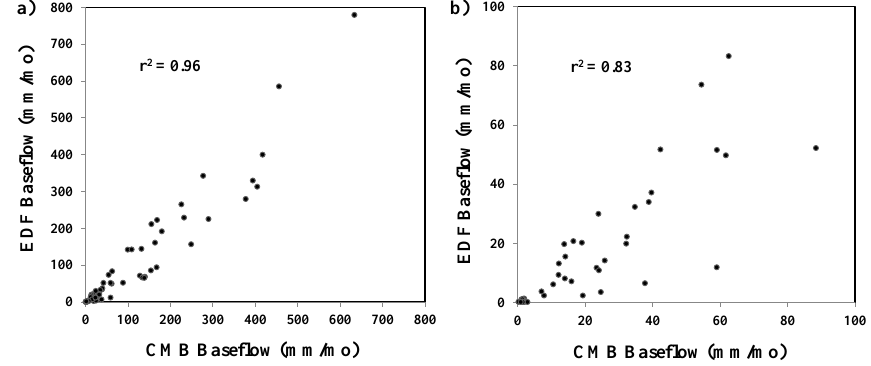
Figure 6. Monthly plots of baseflow from the conductivity mass balance (CMB) and Eckhardt digital filter calculations; (a) includes all months ( r 2 = 0.96) and (b) includes months with less than 100 mm of baseflow ( r 2 = 0.83).